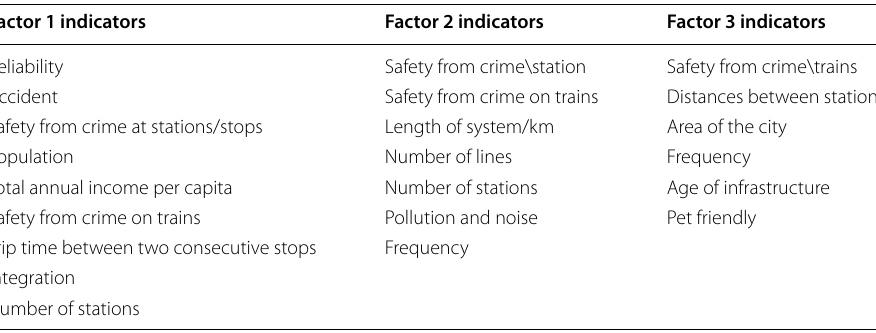
Table 5 Table of classification of variables into three groups according to the variable’s variances Factor 1